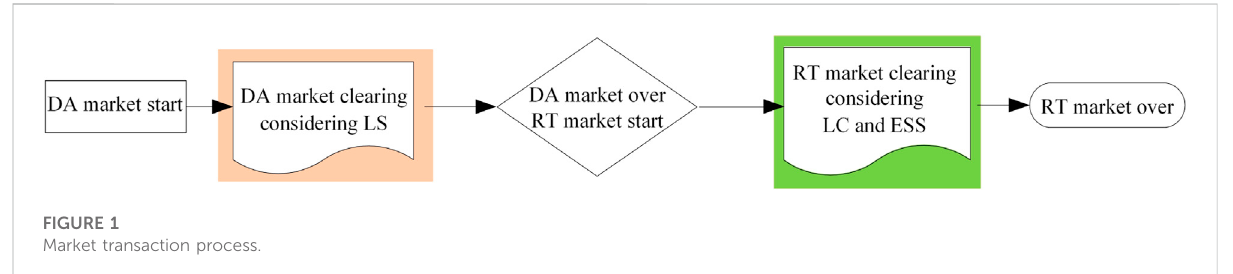
FIGURE 1 Market transaction